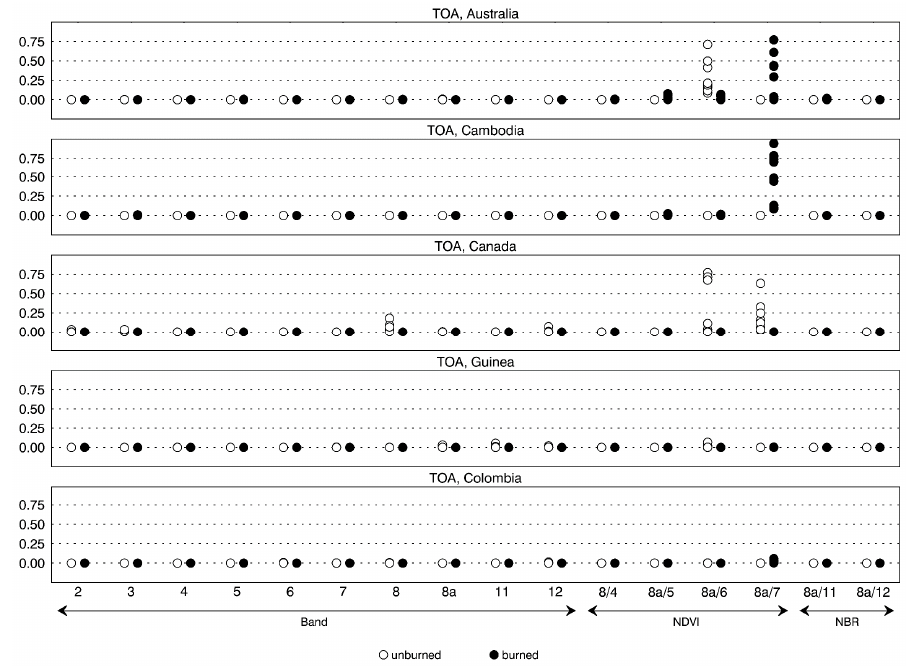
Figure 2. Shapiro-Wilk normality test p -values for the top of atmosphere (TOA) unburned and burned MSI band (Table 2) and spectral index values (Table 3). High p -values indicate that the null hypothesis that the data came from a normally distributed population cannot be rejected, i.e., that the data are normally distributed.